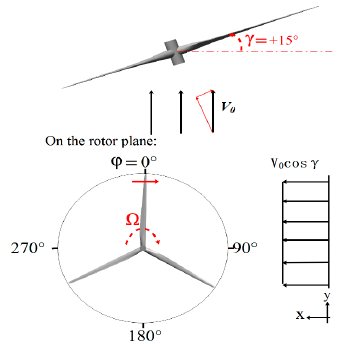
Figure 1. Sketch of the asymmetric relative velocity under yaw.